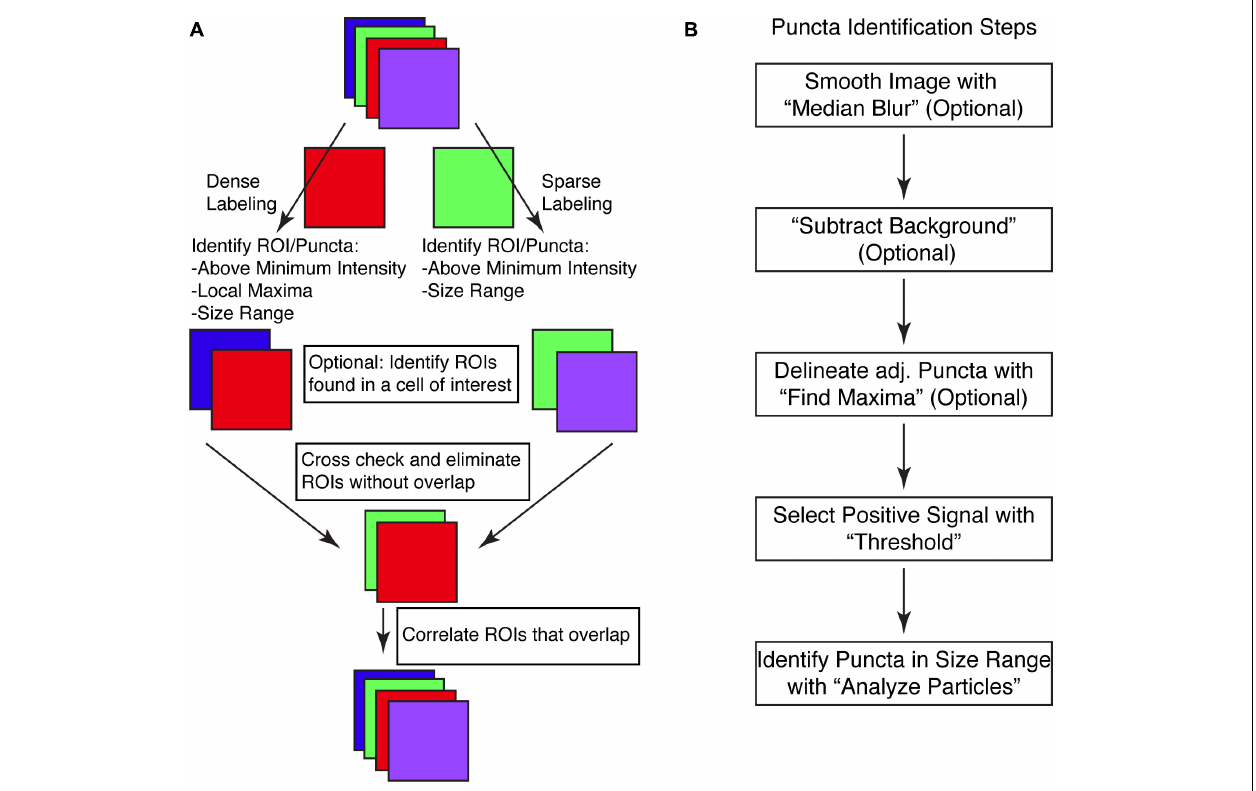
FIGURE 1 | SynapseJ identifies putative synaptic contacts through identification of puncta in single channels and then examines overlap between channels. (A) Initial analysis of pre- or post-synaptic puncta is dictated by the density of puncta in the image. Before identifying and correlating pre- and post-synaptic puncta, one or both channels may be selected for overlap with a cell-specific marker. The final multi-channel image recombines data from each channel, using only the processed image. (B) The identification of puncta proceeds through only a few steps. Smoothing the image with “Median Blur” removes shot noise in the image. A non-uniform hazy background is removed with “Subtract Background.” For densely labeled images, adjacent puncta are delineated with “Find Maxima.” Ultimately, densely and sparsely labeled images are analyzed for puncta by selecting a “Threshold” intensity for positive signal, followed by “Analyze Particles” to remove puncta not within the appropriate size range. Once completed, a list of puncta are identified for that single